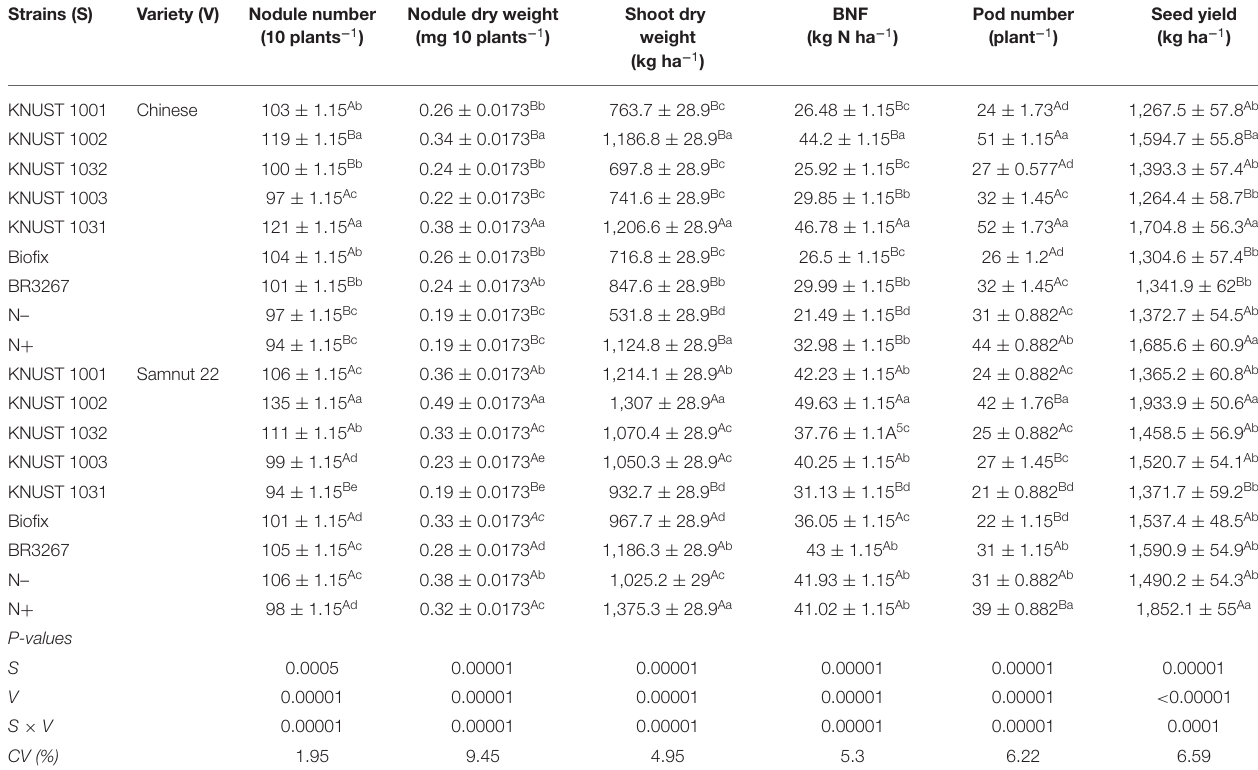
TABLE 2 | The response of groundnut to rhizobia inoculation and mineral N application at Cheshegu. Strains